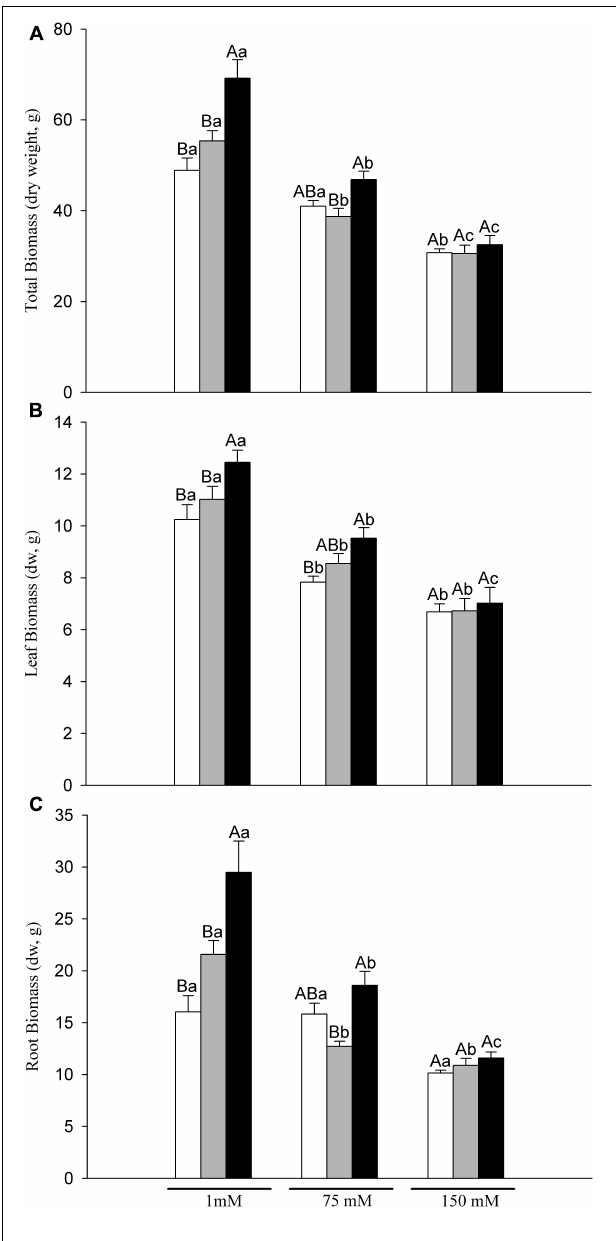
FIGURE 2 | Total biomass (A) , leaf (B) and root (C) dry weight of control (C, white bar), phosphorus (P, gray bar) and arbuscular mycorrhiza plants (AM, black bar) grown at 1, 75 and 150 mM NaCl. Values are mean ± SE of six replicates. Different capital letters indicate significant differences among nutritional levels (C, P and AM) within the same salt level, and lowercase letters indicate significant differences among salt levels within the same nutritional level, from post hoc Tukey test.